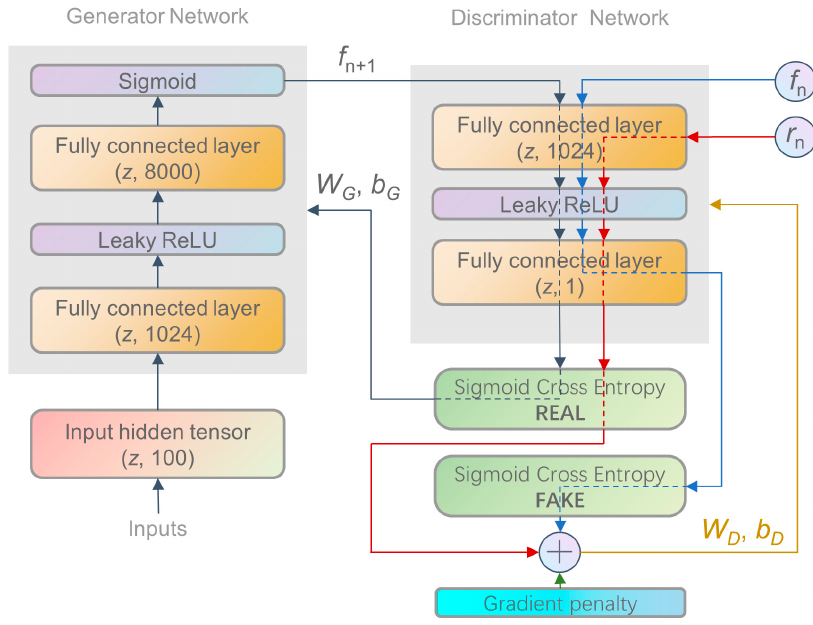
Figure 2. Structure of the US-WGAN showing the generator and discriminator networks.